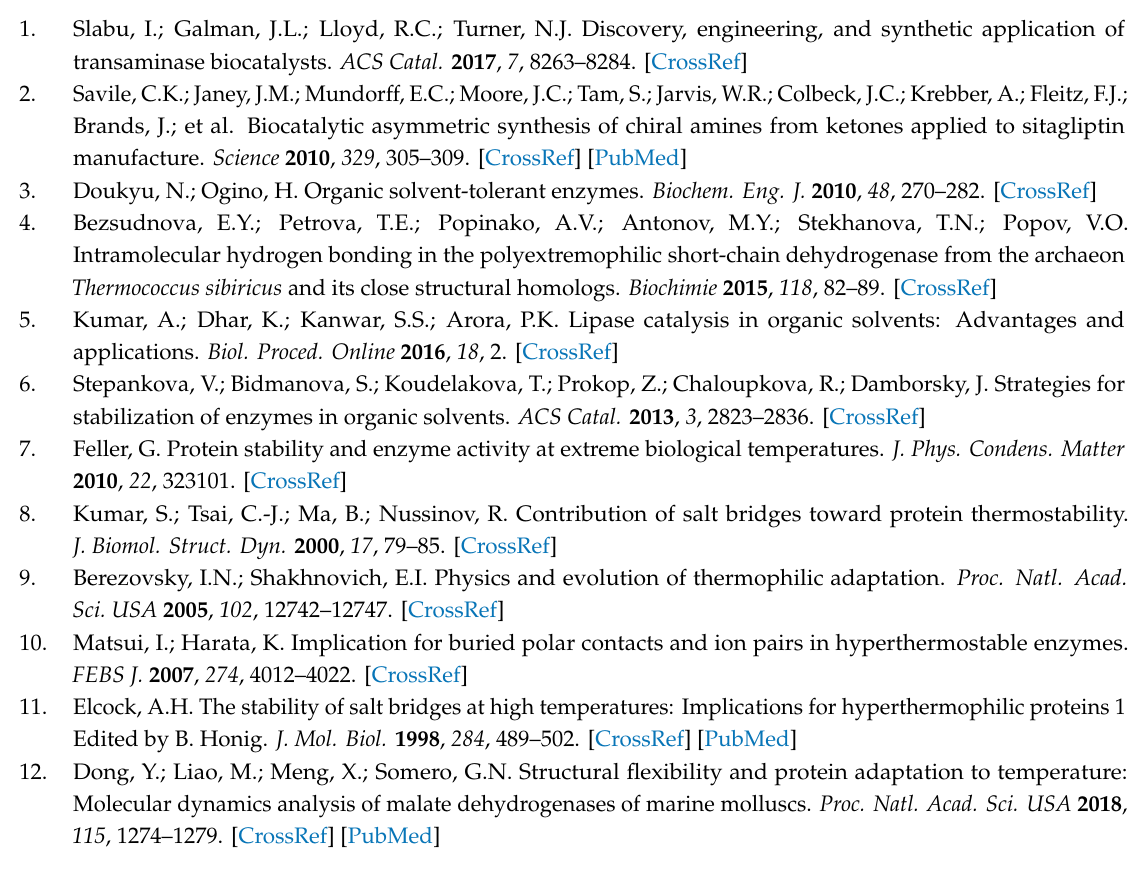
Dimer of TA from TA from TA from TaTT T. uzoniensis B. pseudomalle E. coli 316 295 307